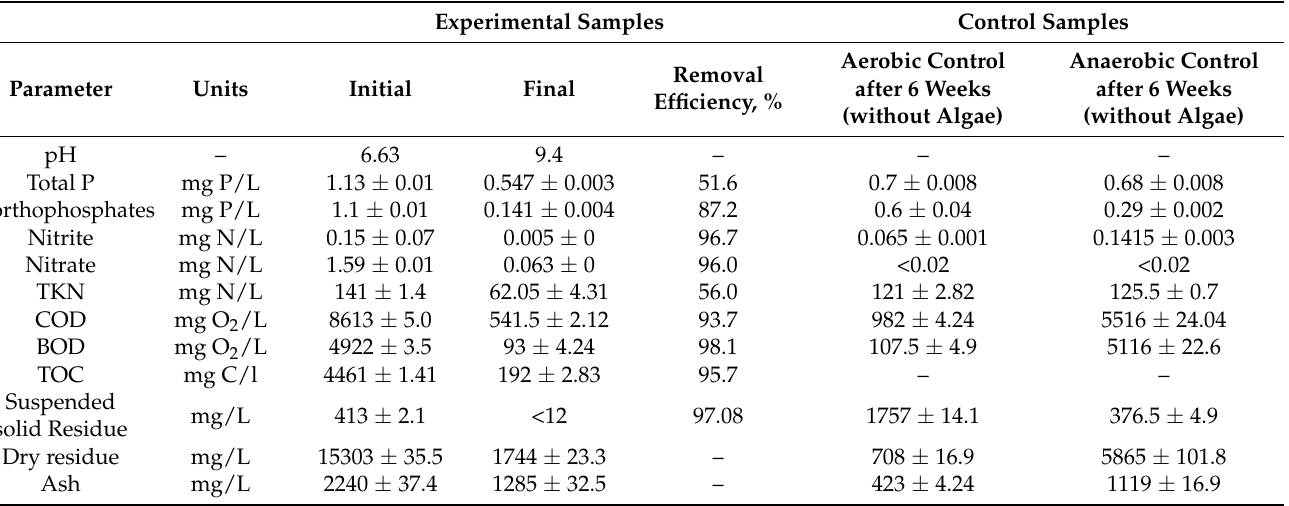
Table 2. Physicochemical characterization and removal efficiency of certain components in the initial sugar plant wastewater and the wastewater after microalgae treatment during the main